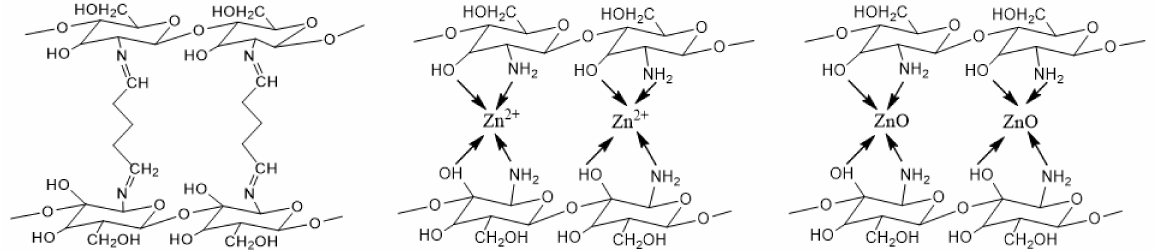
Figure 1. Schematic presentations of the interactions of chitosan with glutaraldehyde; chitosan with Zn ions and ZnO